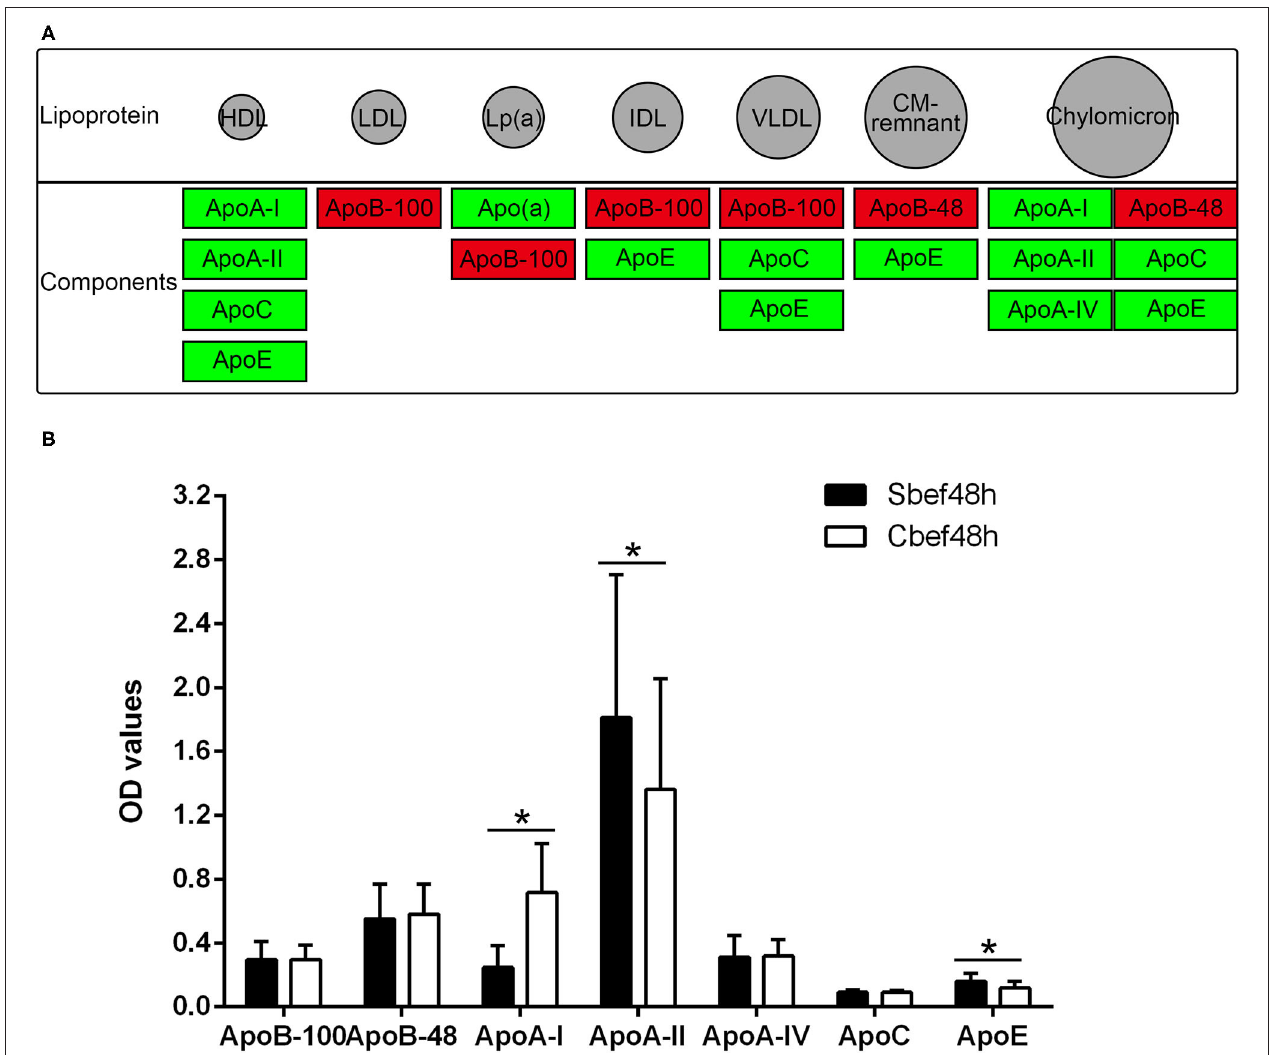
FIGURE 4 | The cholesterol metabolism pathway and Elisa analysis of the components of cholesterol and lipoprotein. (A) hsa04979 KEGG pathway about the cholesterol metabolism (red, increased; green, decreased). (B) Elisa analysis of individual components of cholesterol in plasma. * P <